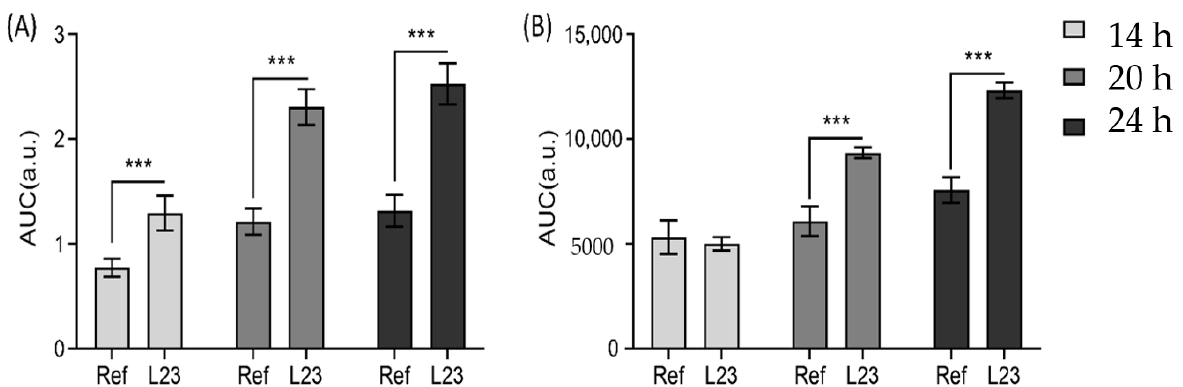
Figure 6. Area under the curve (AUC) comparison of off-line ( A ) and in-line ( B ) measurements between formulation with enhancers (L23) and formulation without enhancers (Ref) at different time points (14, 20 and 24 h). *** p < 0.001. Mean ± SD ( n ≥ 9).